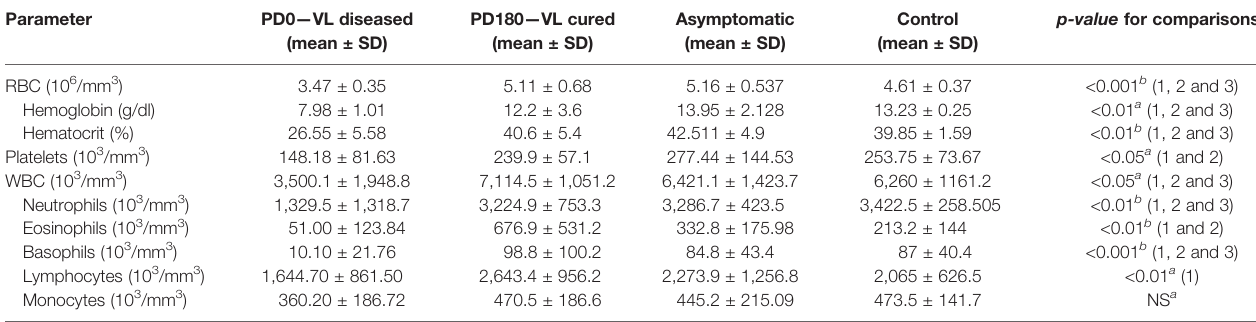
TABLE 2 | Hematological data of the groups analyzed in this study.